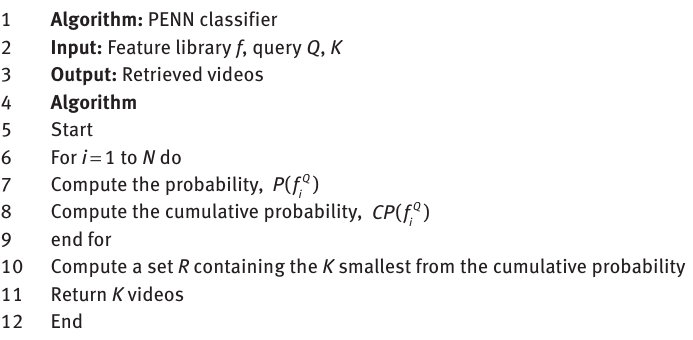
Table 1: Algorithm of the PENN